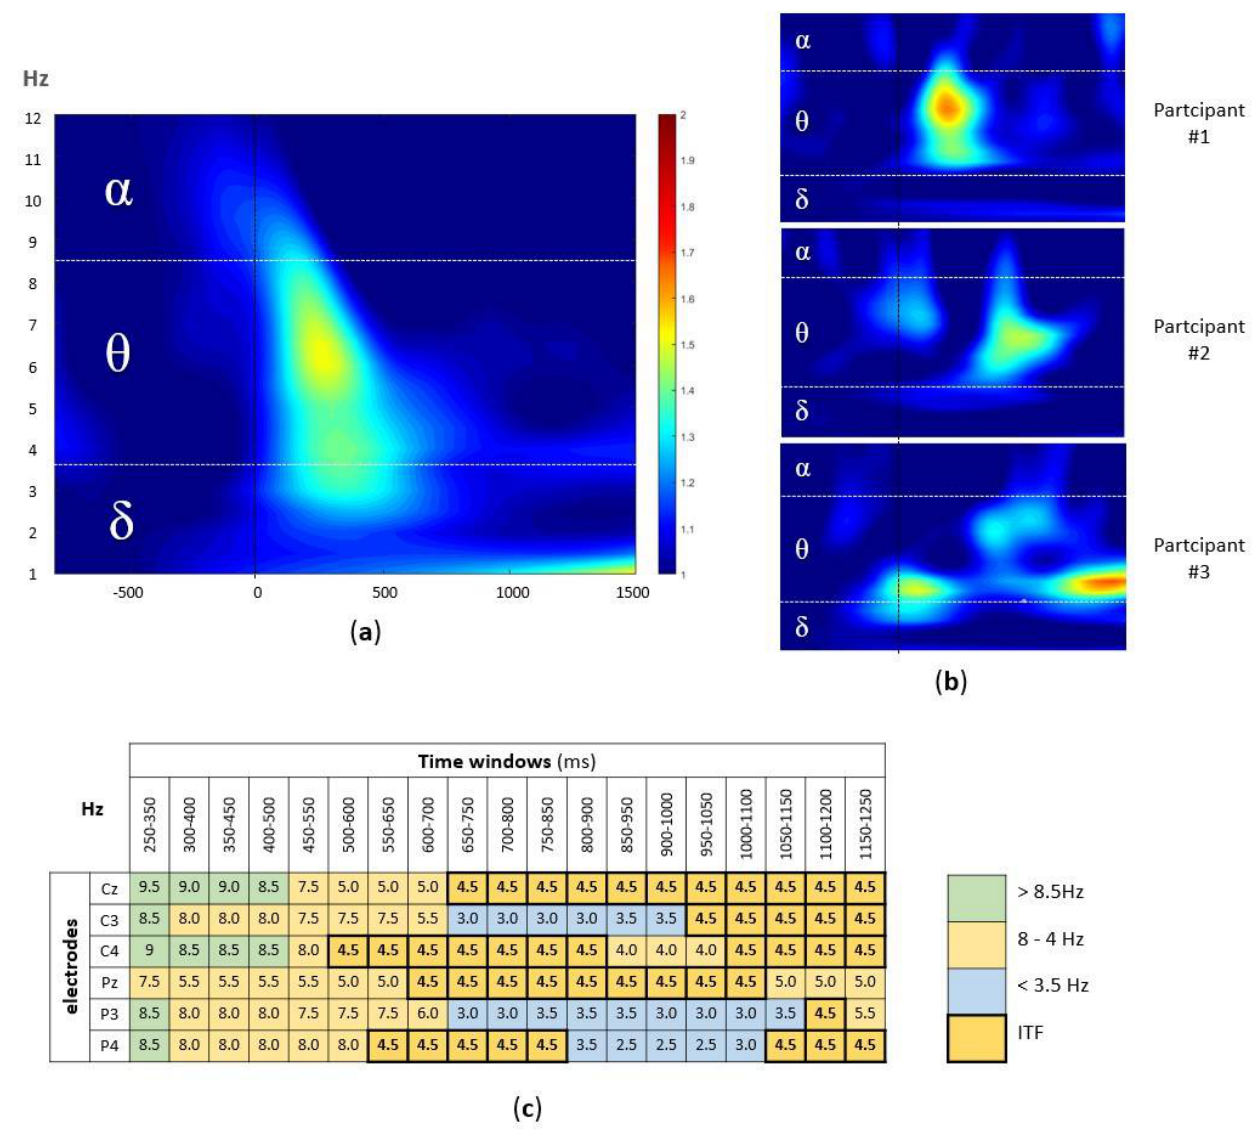
Figure 2. ( a ) The group-level time-frequency plot of the EEG signal during the successfully encoded pairs. The ERSP values, averaged across participants and electrodes, were plotted within the window of − 800 and 1250 ms (x-axis), with stimulus onset marker (black line) and 1–12 Hz (y-axis) split into alpha, theta, and delta band. ( b ) The examples of individual time-frequency plots (three participants); the same x-axes and y-axes as well as color coding as in ( a ) were used. ( c ) The example of participant-level time x electrode matrix with Hz with highest ERSP value in each cell, marked according to the alpha (green), theta (orange), and delta (blue) band, with ITF of 4.5 Hz, i.e., modal value marked bold.